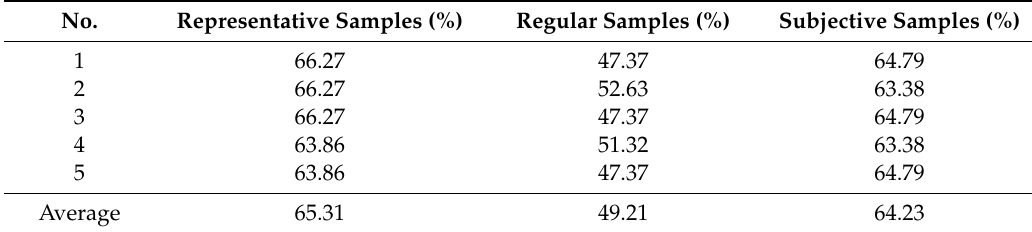
Table 4. Accuracy of the integrated model trained with a di ff erent sample